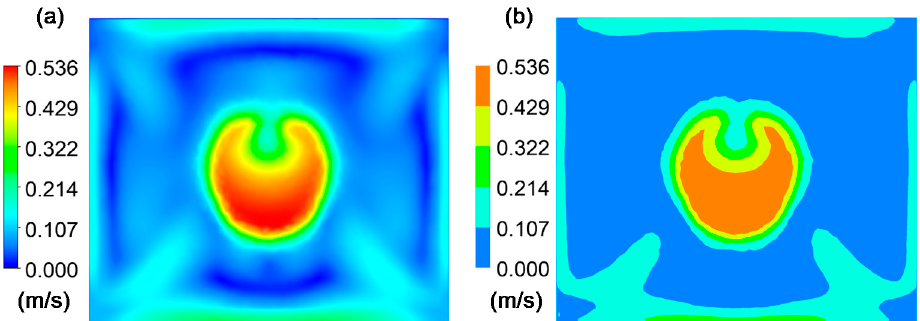
Figure 6. Contours of the velocity magnitude in the cross-section plane at a = 80 mm ( zy -plane): ( a ) continuous contour and ( b ) five-level contour.